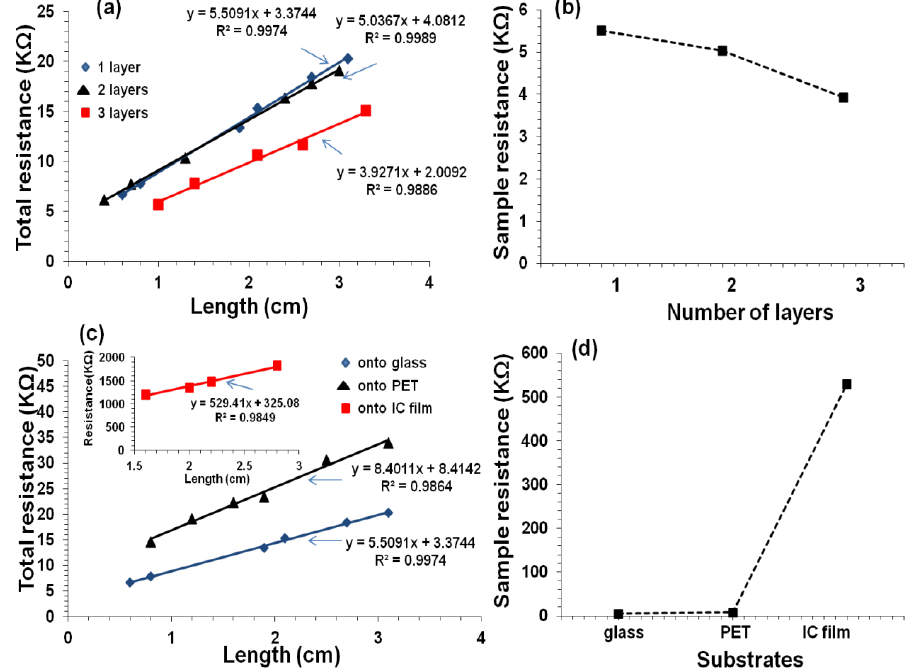
Figure 13. Resistance vs. length for extruded patterns of G-MWNT ink. ( a ) 1–3 printed layers on microscope glass substrates and ( b ) sample resistance of 1–3 printed layers on microscope glass substrates, derived from the slope of the lines in ( a ); ( c ) Resistance vs. length for two printed layers on glass, PET, and IC films (inset) substrates. The inset in ( b ) is present due to the vast different in y-axis values; ( d ) Sample resistance of the tracks printed onto different substrates, derived from the slope of the lines in ( c ).